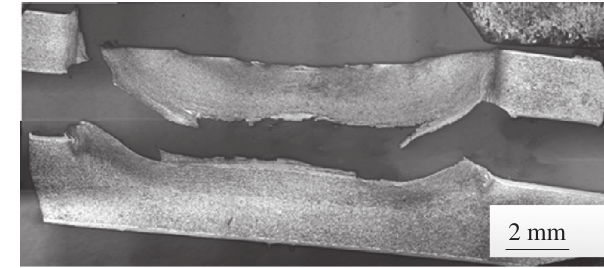
Figure 9: Shear fracture